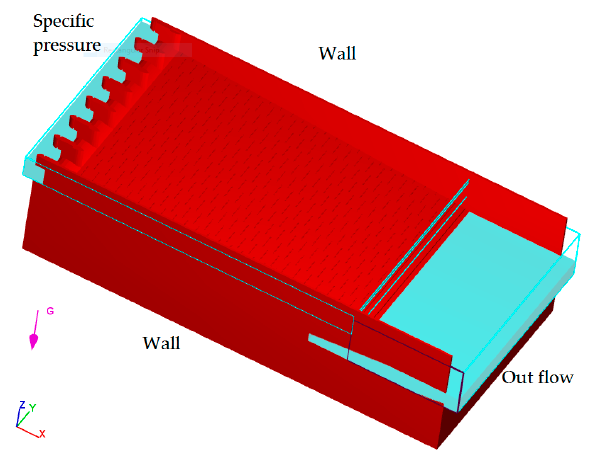
Figure 5. Flow 3D model for Ngan Truoi case study.